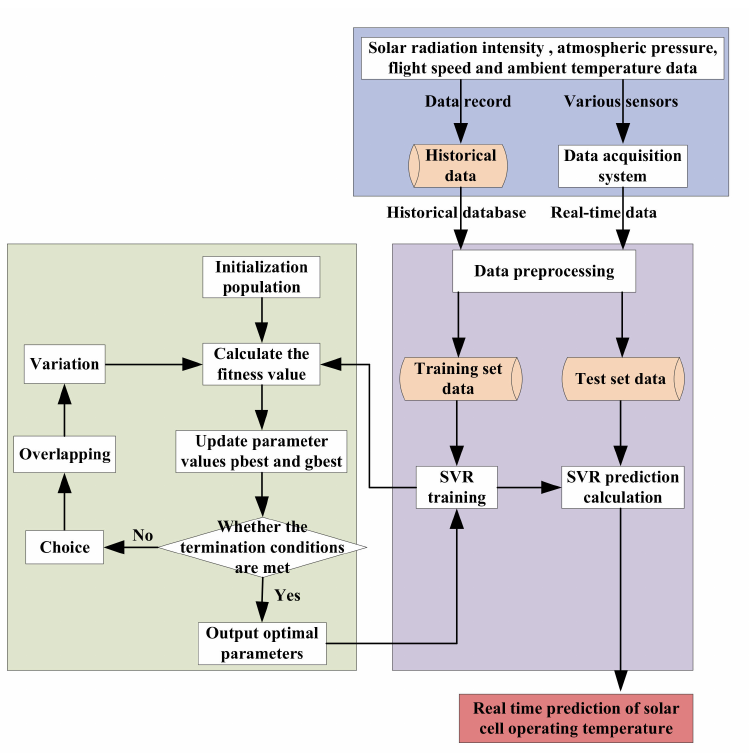
Figure 3. Flow chart for calculating the operating temperature of a solar cell with the PSO- SVM